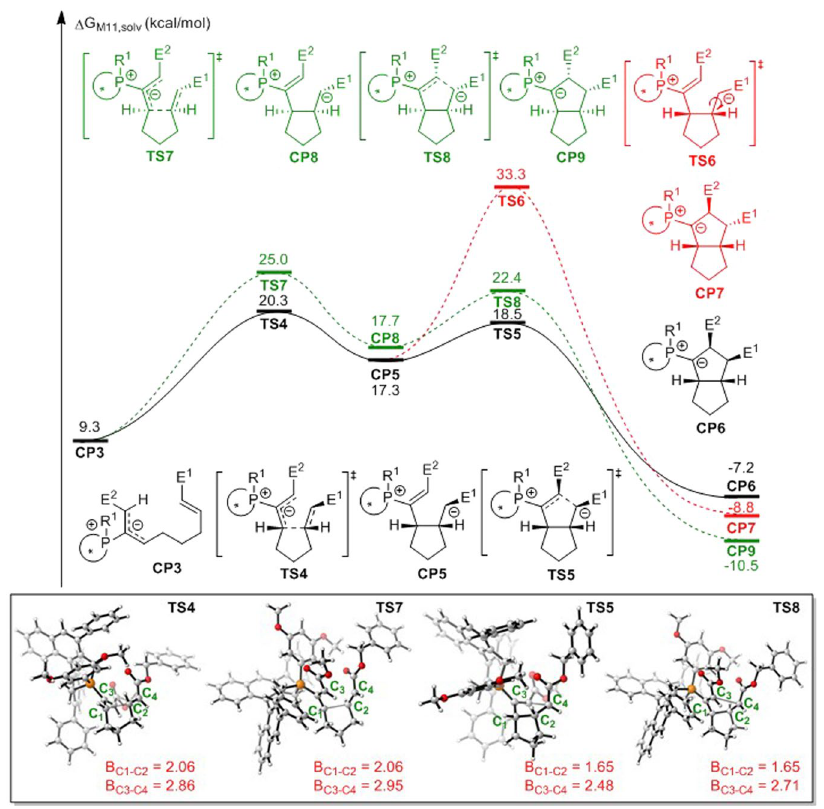
Figure 5. Free energy profiles for the [3 + 2] cycloaddition step of binaphthophosphepine-catalyzed intramolecular annulation from intermediate CP3 (E 1 = CO 2 Bn, E 2 = CO 2 Me). Values are given by kcal/mol and represent the relative free energies calculated by M11 method in toluene solvent. The values in geometry information are given by